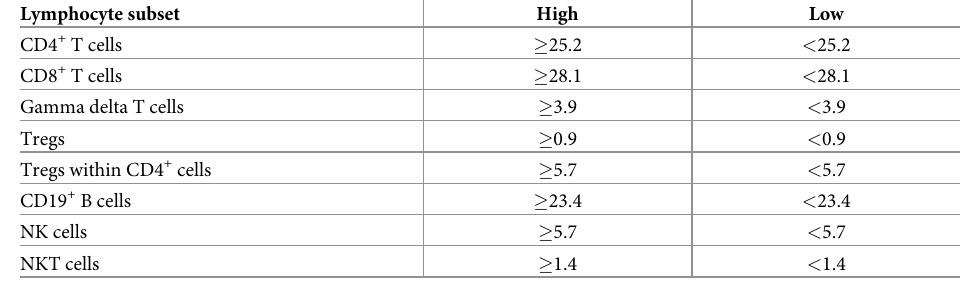
Table 3. Stratification of the juvenile-onset systemic lupus erythematosus patients by the median percentage of each lymphocyte subset.